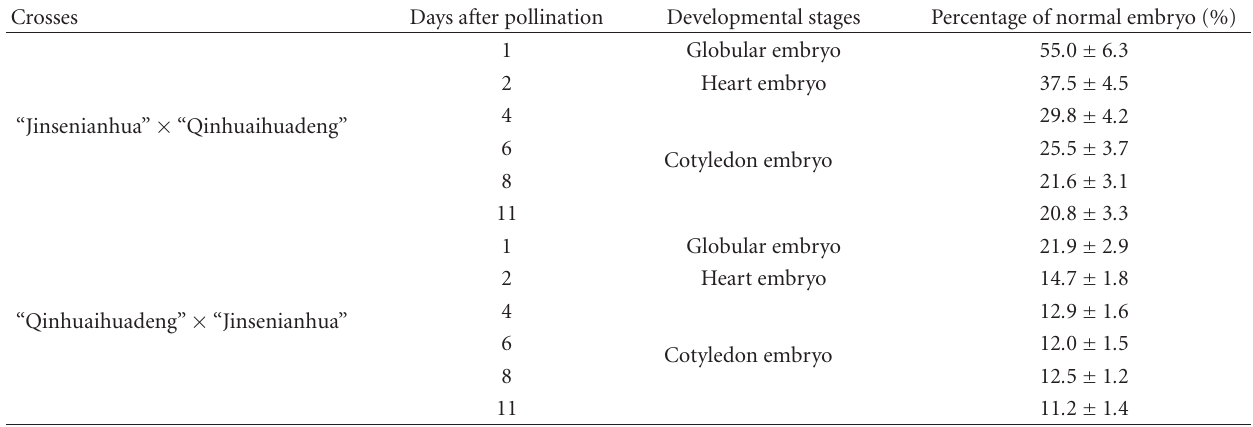
Table 2: Number of normal and abnormal embryos at di ff erent days after pollination. Crosses